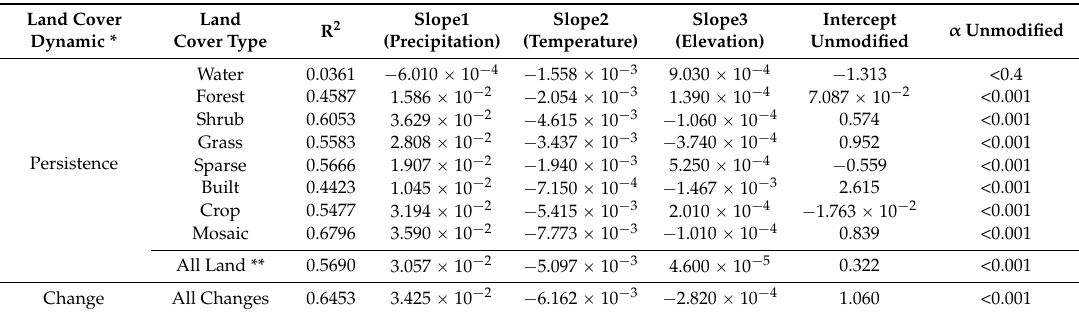
Table 4. Average coefficients of determination, slope, and intercept terms for 2001–2007 series model by land cover type and